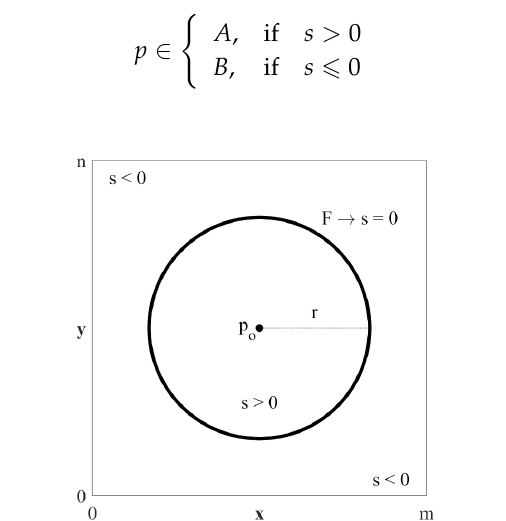
Figure 6. Graphical interpretation of the circular fault properties.